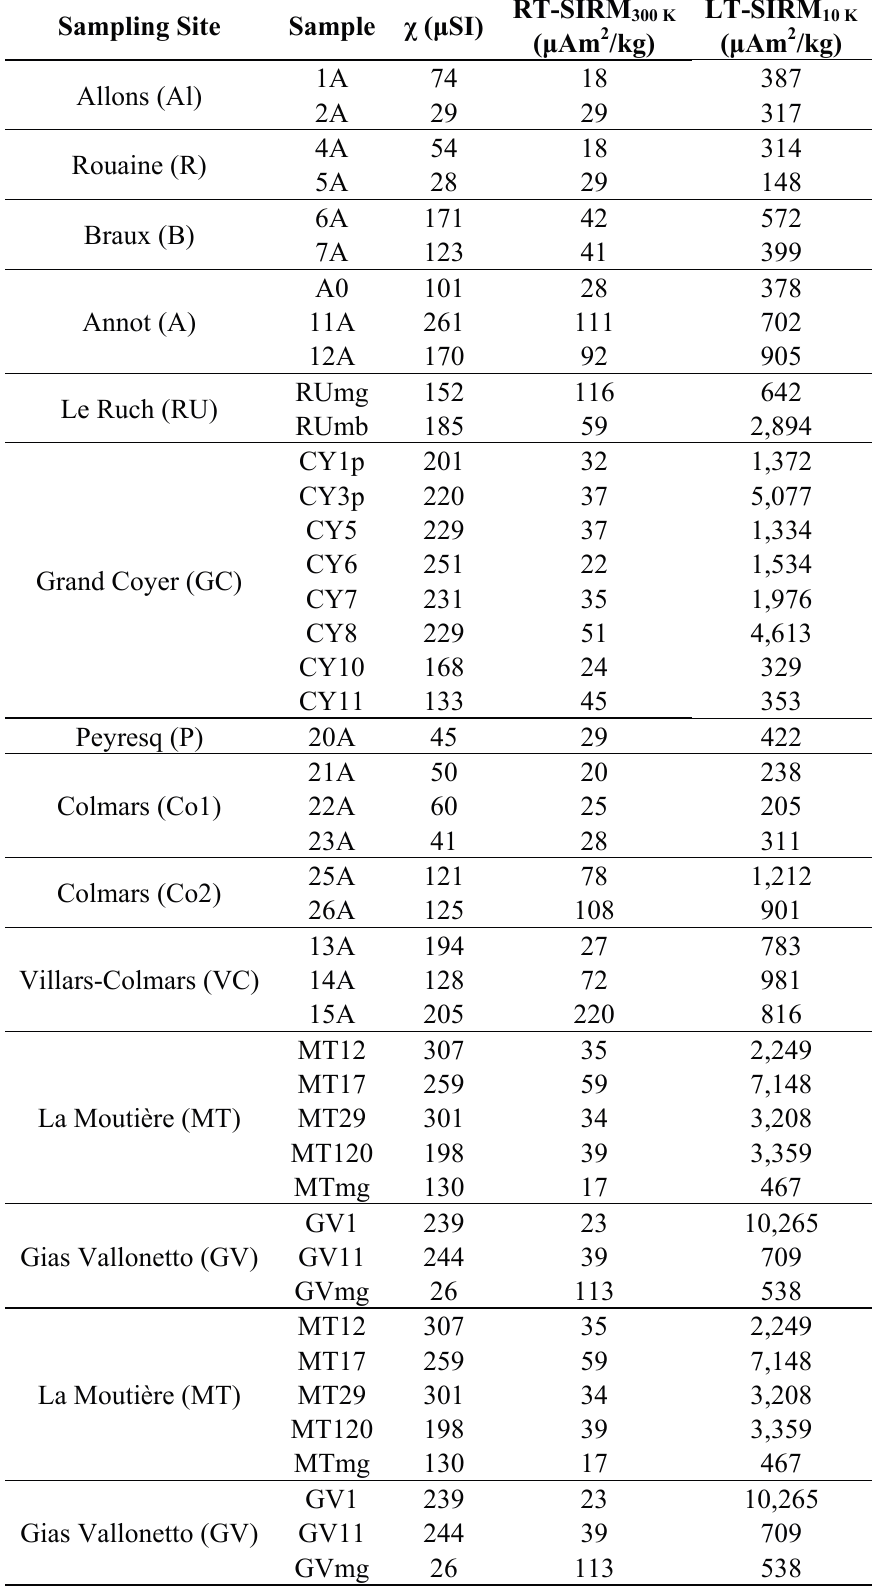
Table 2. Magnetic data and low temperature magnetic features for the collected samples. χ : low field magnetic susceptibility; RT-SIRM remanent magnetization at 300 K; LT-SIRM remanent magnetization at 10